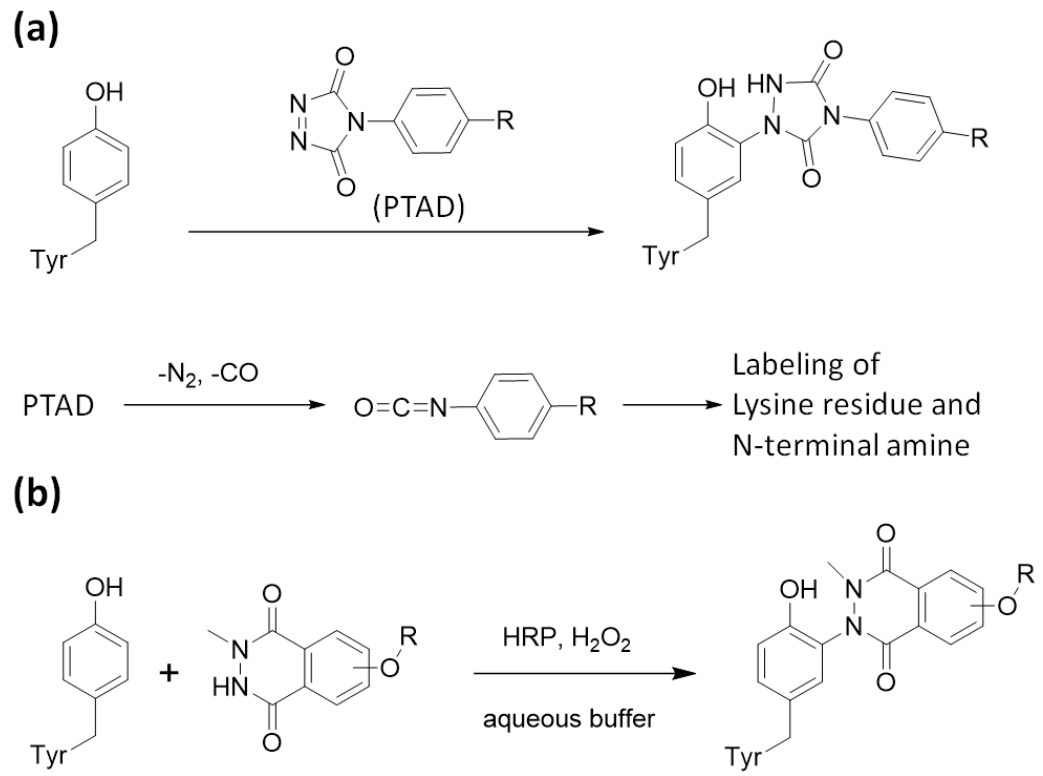
Figure 2. Tyrosine labeling with PTAD and N -methylated luminol derivatives. ( a ) Tyrosine labeling with PTAD and side reaction with amine group via isocyanate generation. ( b ) Tyrosine labeling with N -methylated luminol derivative in the presence of HRP and H 2 O 2 .